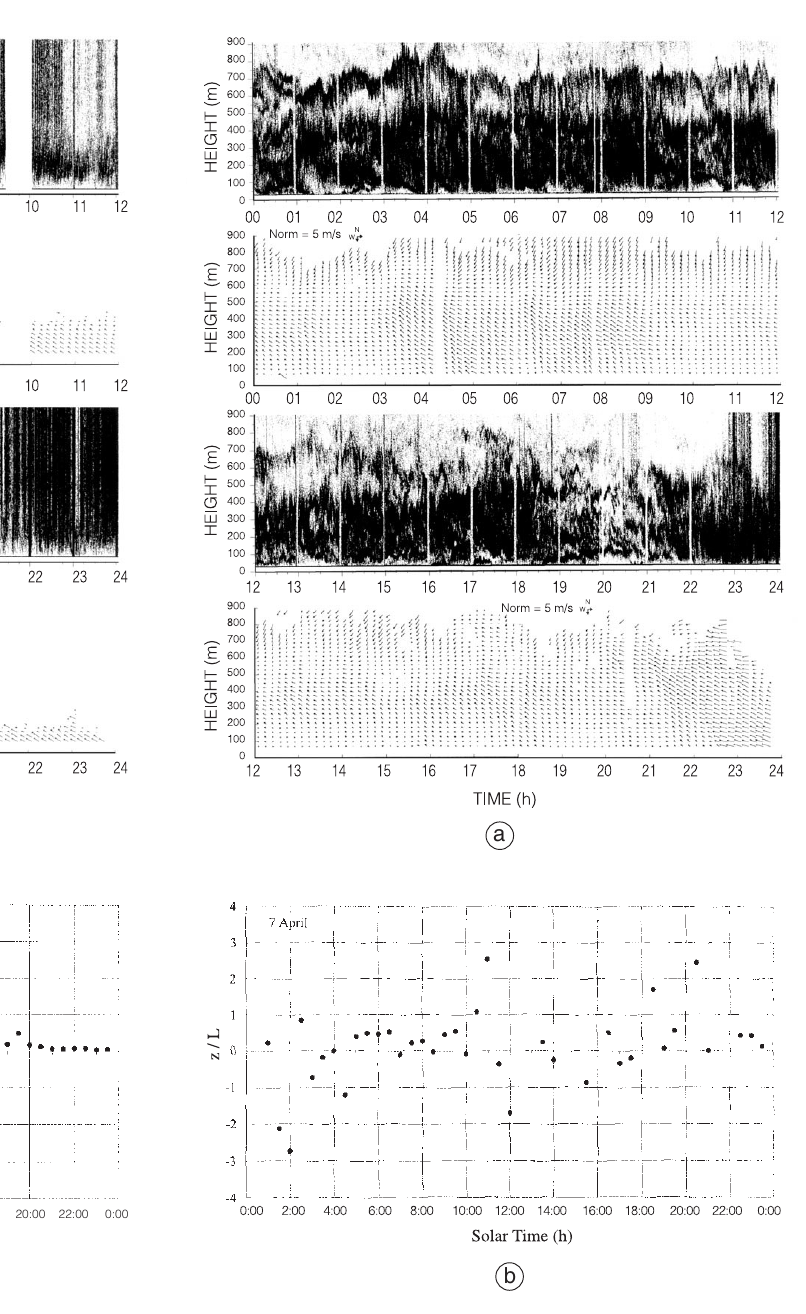
Fig. 6a,b. a) Sodar facsimile and horizontal velocity recorded at Ny-Ålesund on March 26, 1998 during forced convection; b) stability parameter z/L as a function of solar time.